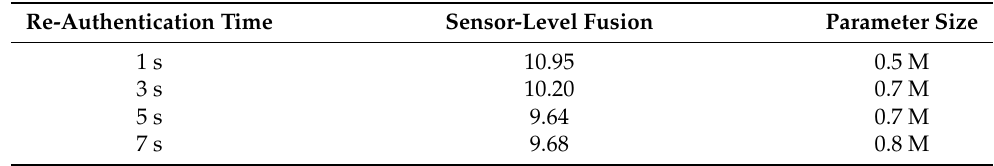
Table 6. Averaged EERs ( % ) of the sensor-level fusion for different re-authentication